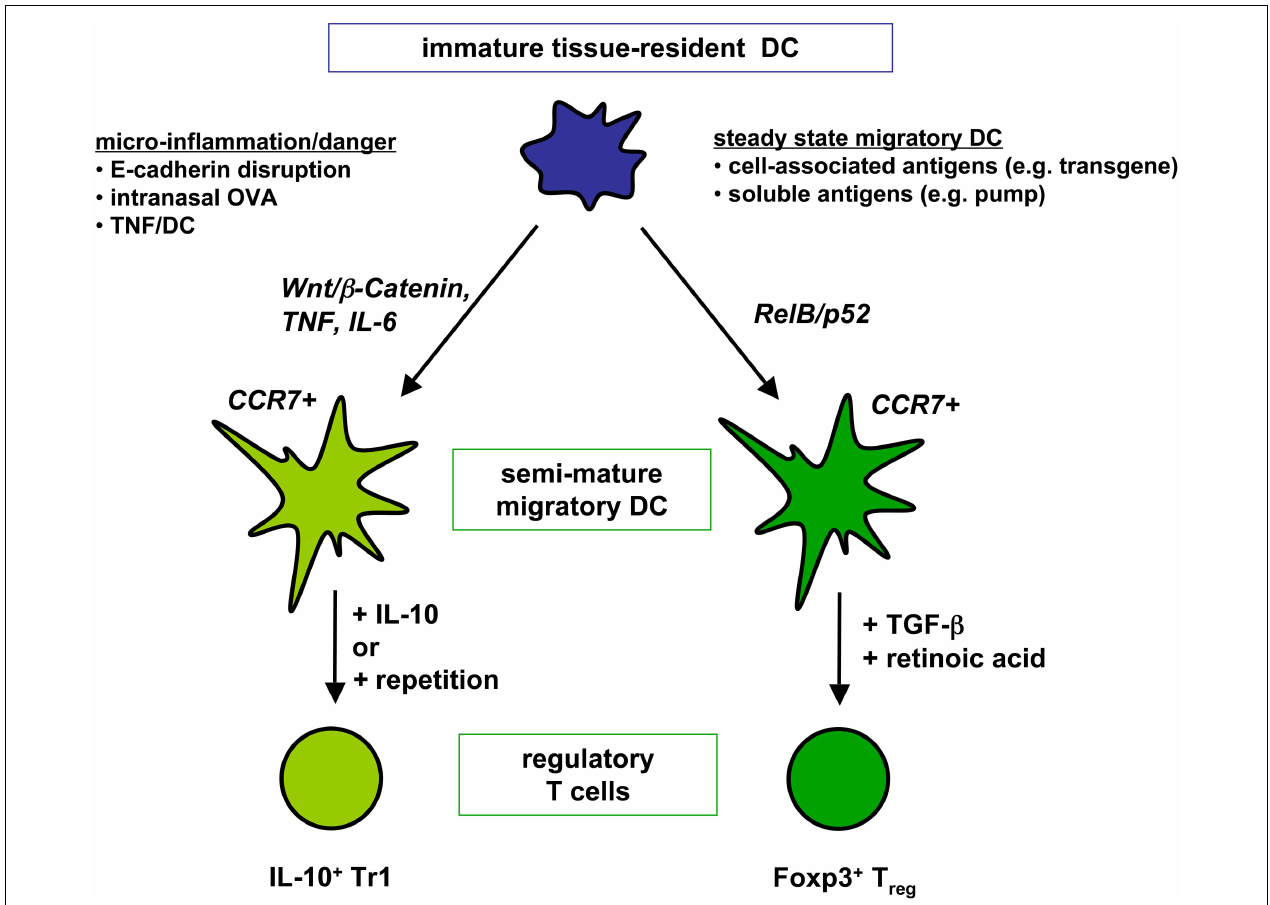
Alternatively, repetitive injections of IL-10-deficient semi-mature DC also lead toTr1 cell generation. Different, only incompletely understood maturation pathways activate tissue-resident DC into RelB/p52 + semi-mature DCs homing to theT cell areas of peripheral lymph nodes.Transport of soluble and cell-associated antigens have been observed for ssmDCs. By usingTGF- β and retinoic acid naiveT cells are converted into Foxp3 + Tregs by